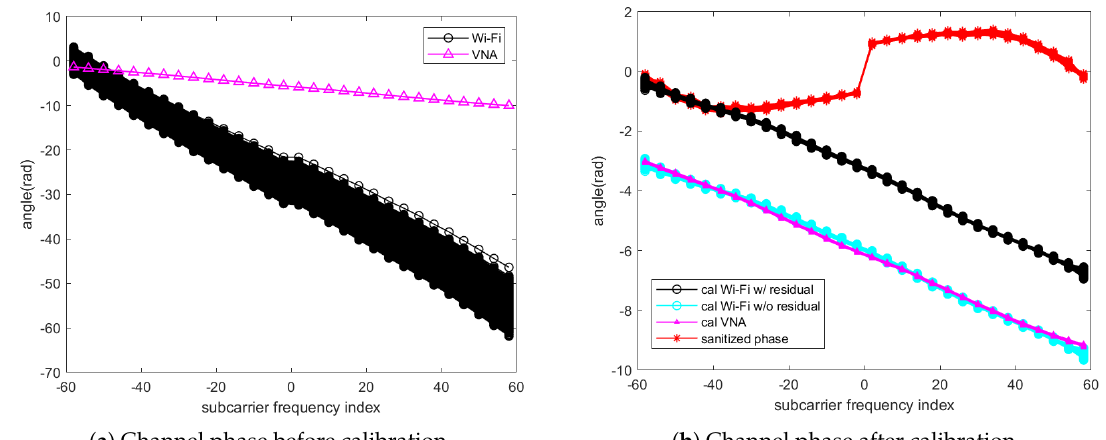
Figure 9. Comparison of phase of the calibrated CSI to the calibrated channel measured from VNA and phase sanitization method ( a ) before and ( b ) after